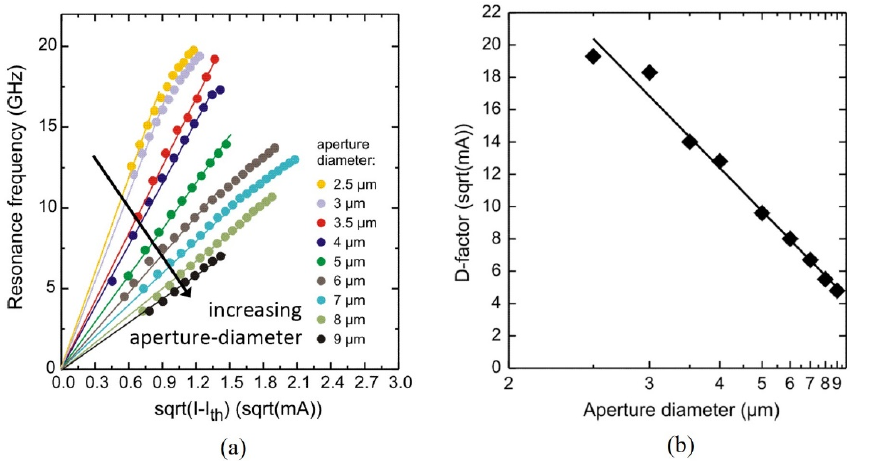
Figure 3. EDR, HBR, EDR mod , HBR mod , and current density at error-free 25 Gb/s operation versus the oxide-aperture diameter [42].